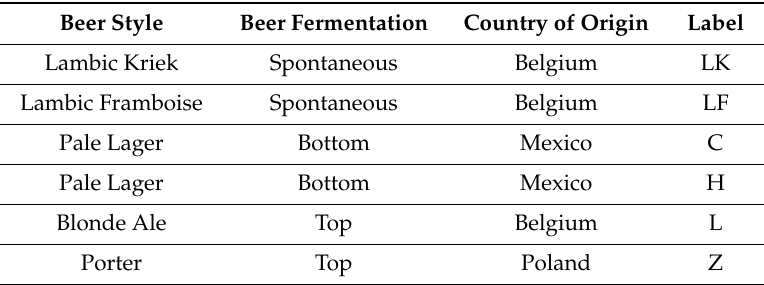
Table 1. Beer styles and labels of samples used to report